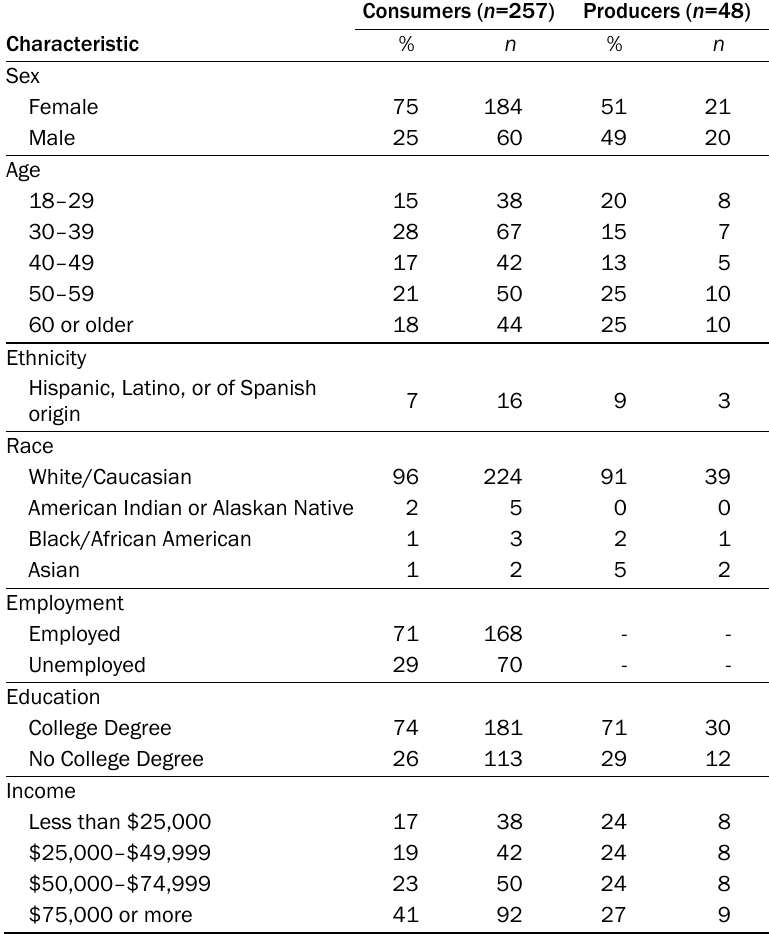
Table 1. Characteristics of the Consumer and Producer Samples